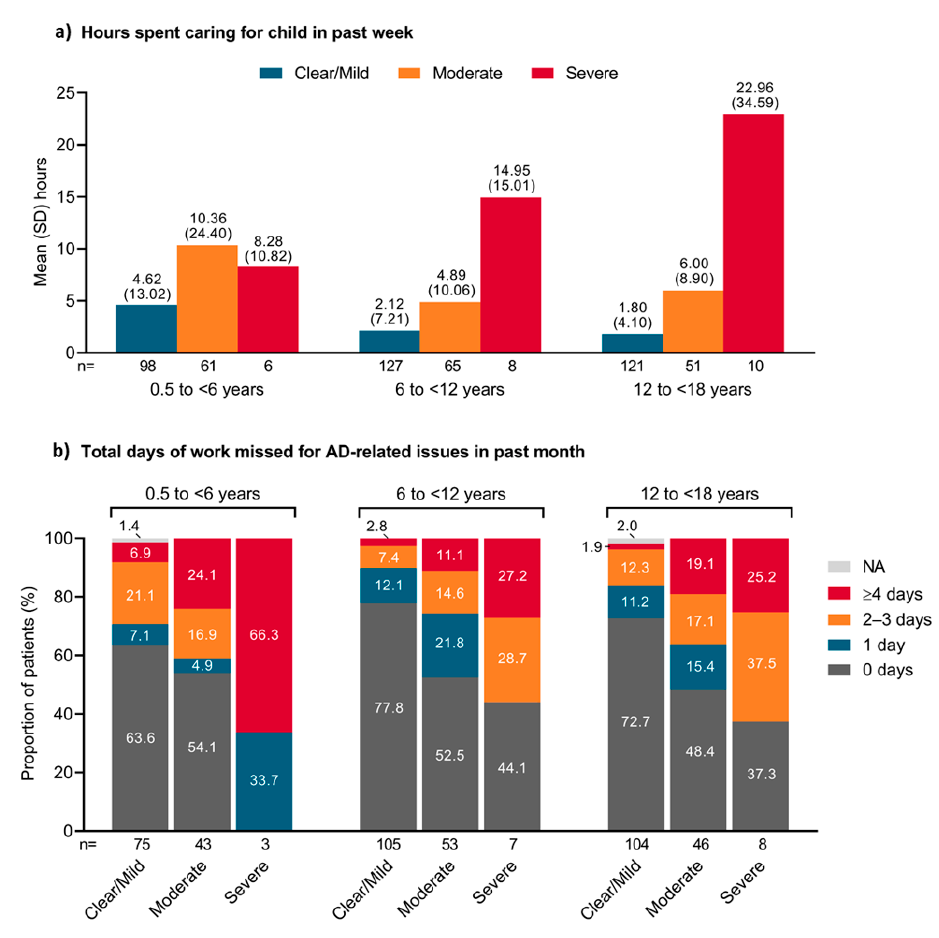
Figure 2. ( a ) Mean hours spent caring for child in the past week; ( b ) total days of work missed for atopic dermatitis-related issues in the past month for parents/caregivers of Japanese pediatric patients across age groups. AD, atopic dermatitis; NA, not applicable; SD, standard deviation.